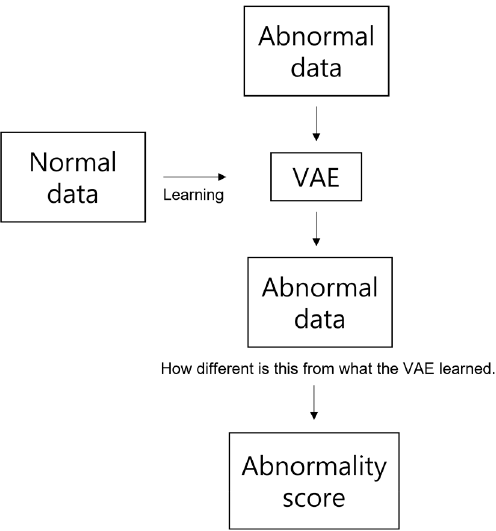
Figure 9. Abnormality score extraction process.